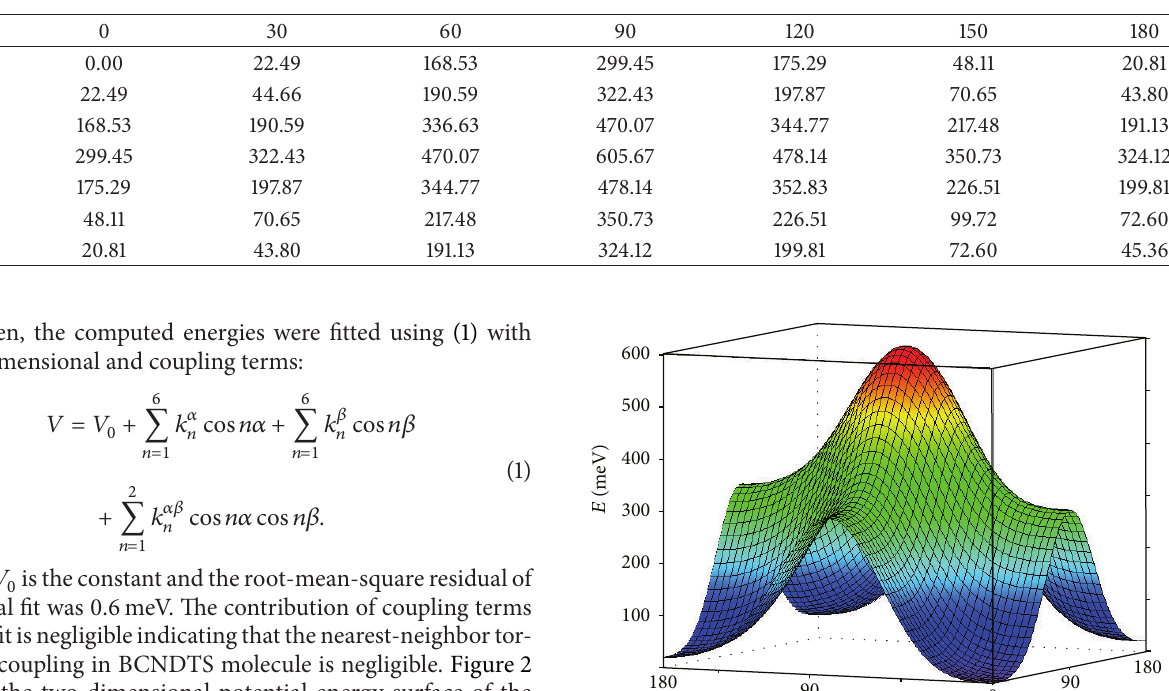
Table 2: Computed energies of BCNDTS molecule in meV at constrained values of 𝛼 and 𝛽 .